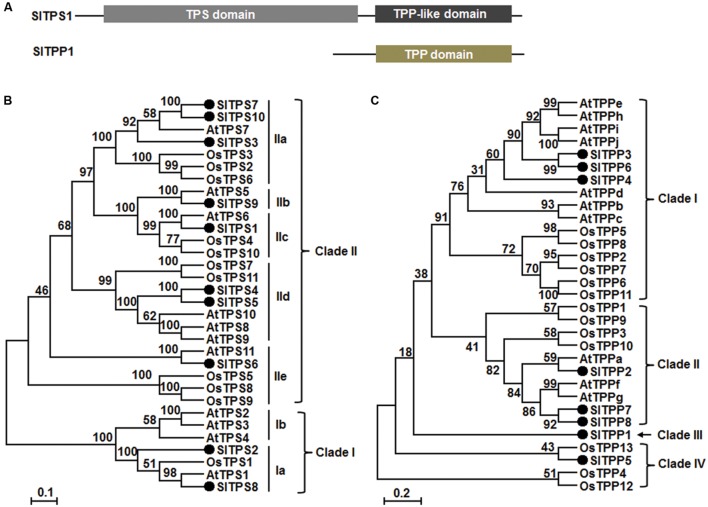
Structural features and phylogenetic tree of SlTPSs and SlTPPs with Arabidopsis and rice TPSs and TPPs.
(A) Structures of SlTPS1 and SlTPP1. Conserved domains are indicated. (B,C) Phylogenetic tree of SlTPSs and SlTPPs. Phylogenetic trees were constructed by neighbor-joining method using MEGA program version 6.05. SlTPSs and SlTPPs in the trees are indicated by filled circles and different clades are labeled at right of the trees.